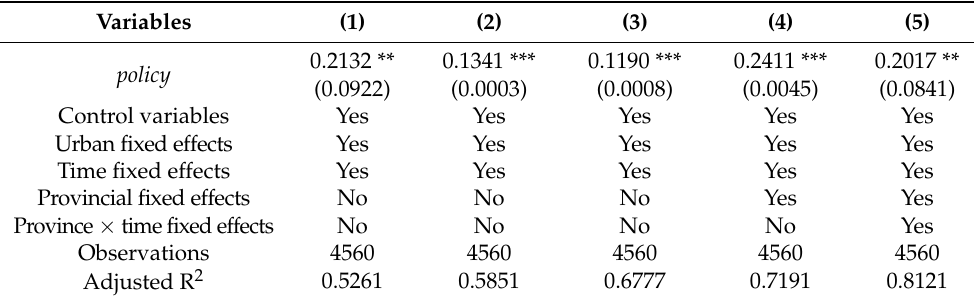
Table 7. Results of variation sample and outlier